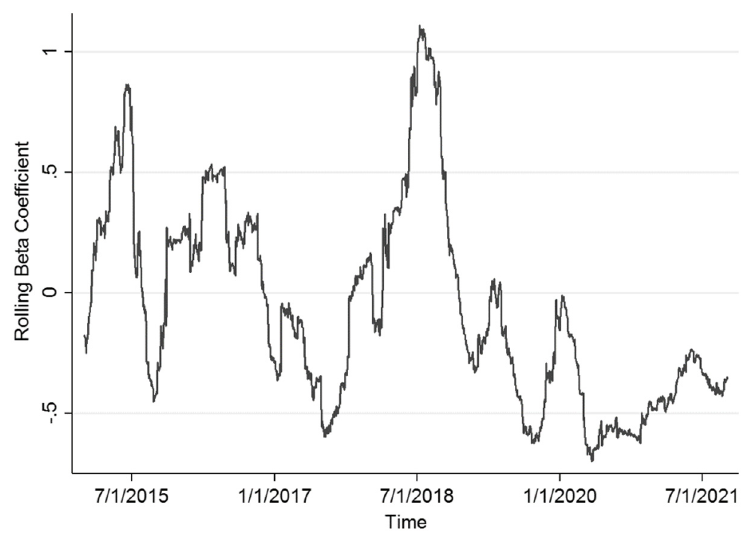
Figure 3. Common shock (rolling) impact on the Intesa San Paolo performance: period January 2015–December 2021. Source: authors’ calculation in Stata on Bloomberg data.